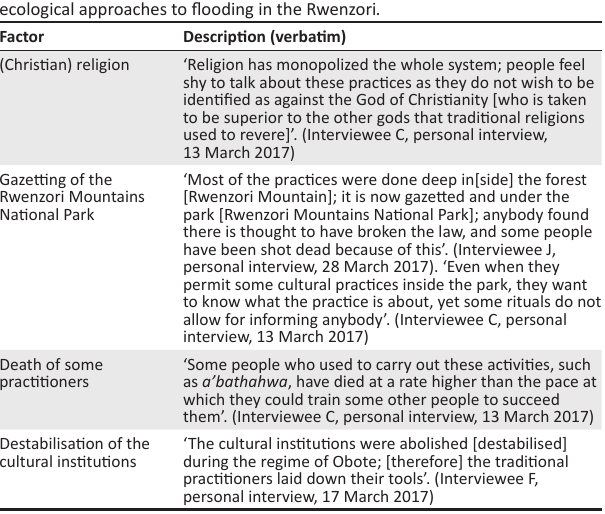
TABLE 2: Verbatim description of factors that could have threatened traditional ecological approaches to flooding in the Rwenzori .